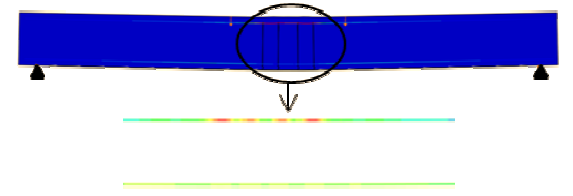
Fig. 12. Stress plots of the rebars in the vicinity of the cracks